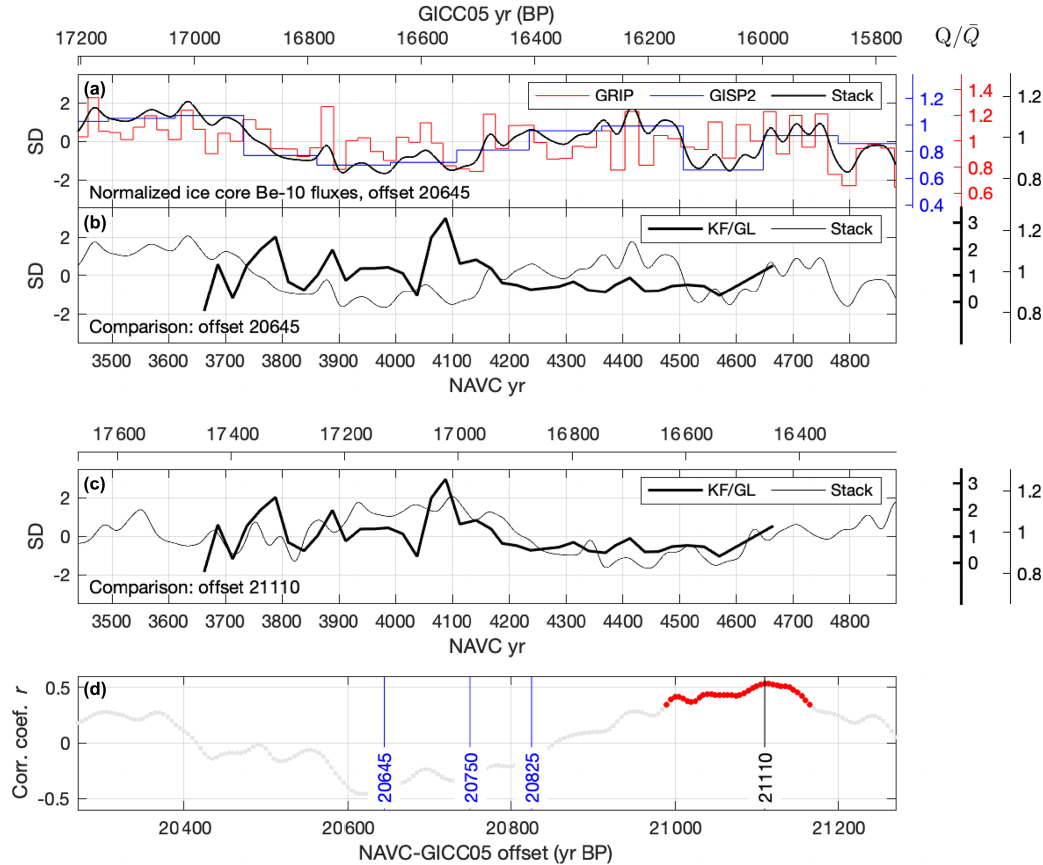
Figure 18. Comparison of the combined 10 Be fallout flux estimate from the KF and GL sites (Fig. 16) with ice core records of 10 Be fallout. (a) Scaled and centered ice core 10 Be flux records from Adolphi et al. (2018) (and references therein), offset to NAVC years with a NAVC– GICC05yrBP offset of 20645 years (see text). “Stack” is the global ice core stack from Adolphi et al. (2018). (b) Scaled and centered combined KF–GL fallout flux estimate compared to the ice core stack with the same 20645-year offset. (c) Same as (b) , only for an offset of 21110 years. In panels (a) – (c) , because the primary plotted units of standard deviations from the mean obscure the true relative variability of each record, the additional axes at right labeled Q/ ¯ Q , which have line colors and weights matching each data series, show units of relative variation with respect to the mean of each data series. This highlights the fact that the apparent magnitude of variations in our reconstructed NAVC fallout flux is greater than expected from coeval variations in ice cores, although, as discussed in the text, this difference could be an artifact of the calculation procedure and we therefore used the scaled records for correlation estimates. (d) Results of correlation analysis comparing the scaled and centered KF–GL fallout flux estimate with the ice core stack. Red highlights values of the offset for which the hypothesis that the two records are uncorrelated can be rejected at 95% confidence. Vertical lines highlight offsets inferred from radiocarbon dating of NAVC varves (20820 or 20645 with the GICC05–calendar year offset of Adolphi et al., 2018, for this time period) and event correlation of varve thickness with Greenland ice core temperature (20825 and 20750; Ridge et al., 2012). All of these yield an inverse correlation between the 10 Be